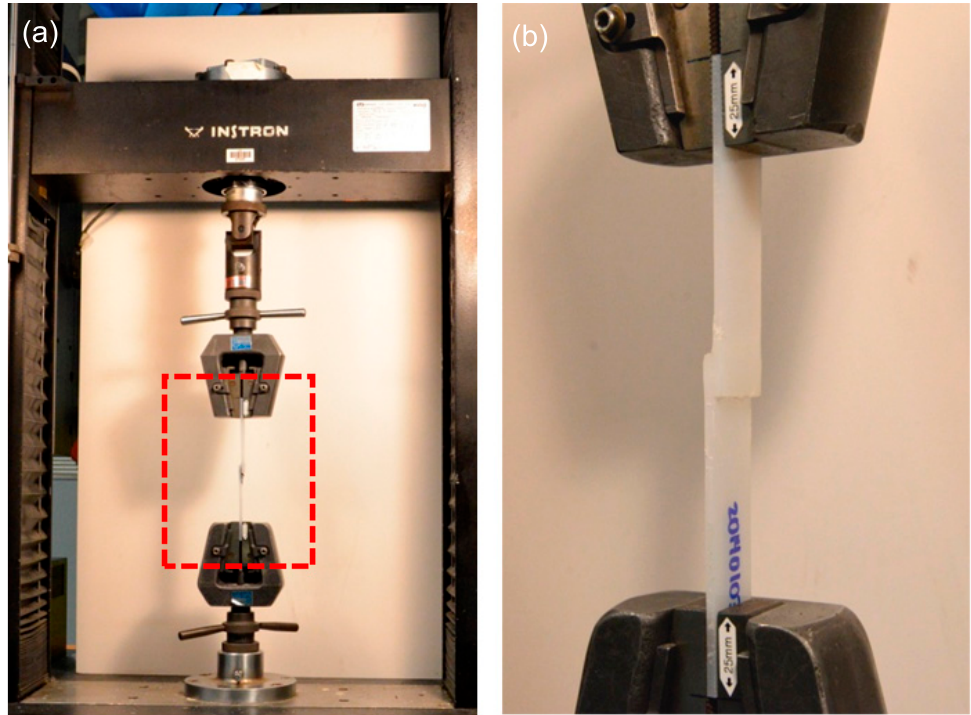
Figure 5. Photos showing a single-joint lap shear undergoing the tensile test in an Instron: ( a ) the entire setup. ( b ) a closer view of the joint (EPON 825/JEFFAMINE D-230) bonded by epoxy, corre- sponding to the region specified by the dotted red box on the left.